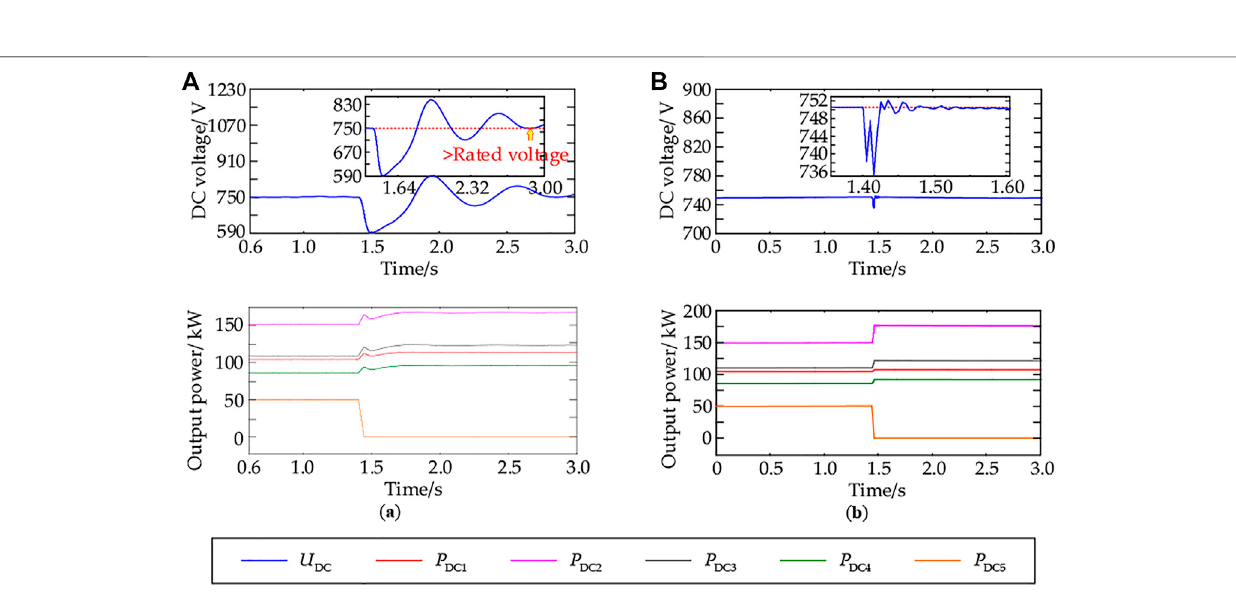
Frontiers in Energy Research |